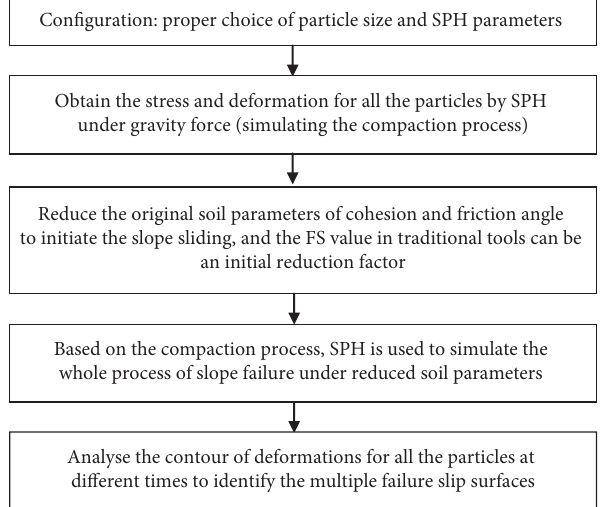
Configuration: proper choice of particle size and SPH parameters